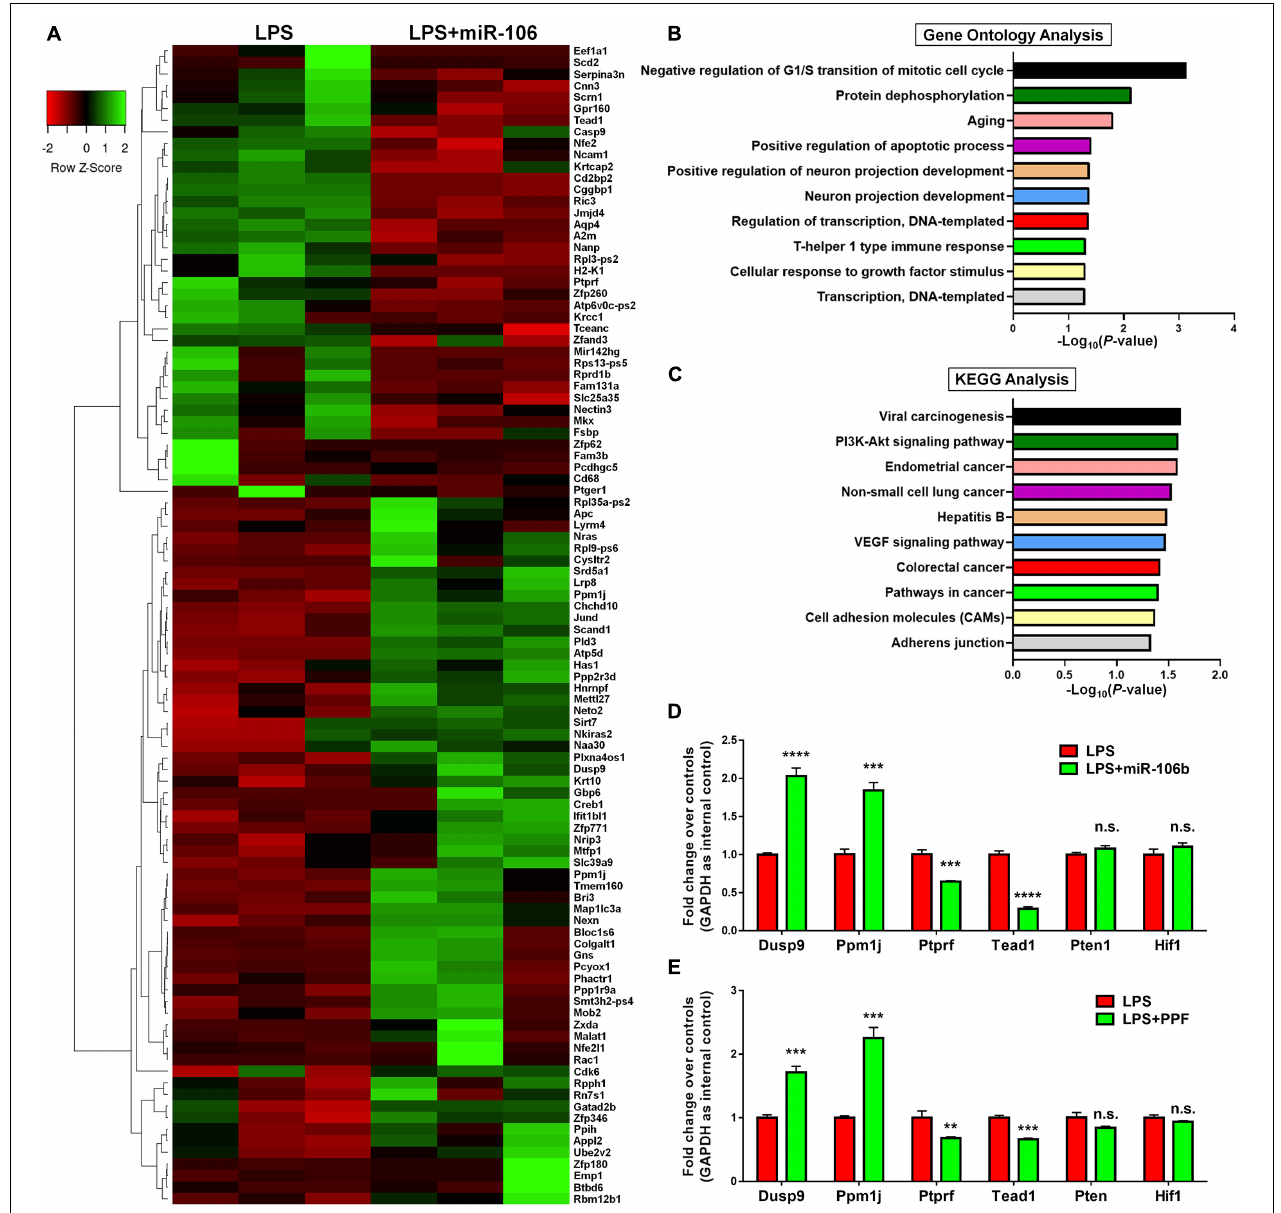
FIGURE 5 | miR-106b significantly alters the gene expression in LPS-stimulated microglia. (A) The heatmap and hierarchical cluster analysis of top 100 genes with the highest fold changes between LPS and LPS + miR-106b GOF groups, identified by RNA-seq assay. (B) The Gene Ontology (GO) analysis of differentially expressed genes between LPS and LPS + miR-106b GOF groups. (C) The Kyoto Encyclopedia of Genes and Genomes (KEGG) analysis of differentially expressed genes between LPS and LPS + miR-106b GOF groups. (D) Independent qRT-PCR analyses of up-regulated ( Dusp9 and Ppm1j ), down-regulated ( Ptprf and Tead1 ), and unchanged genes ( Pten and Hif1 ) identified by RNA-seq assay. (E) The transcript levels of RNA-seq assay-identified up-regulated ( Dusp9 and Ppm1j ), down-regulated ( Ptprf and Tead1 ), and unchanged genes ( Pten and Hif1 ) in propofol-treated microglia were determined by qRT-PCR. Data were represented as mean ± SD from three independent experiments. The symbols **, ***, and **** denote p < 0.01, p < 0.001, and p < 0.0001, respectively. GOF, gain-of-function. n.s. denotes